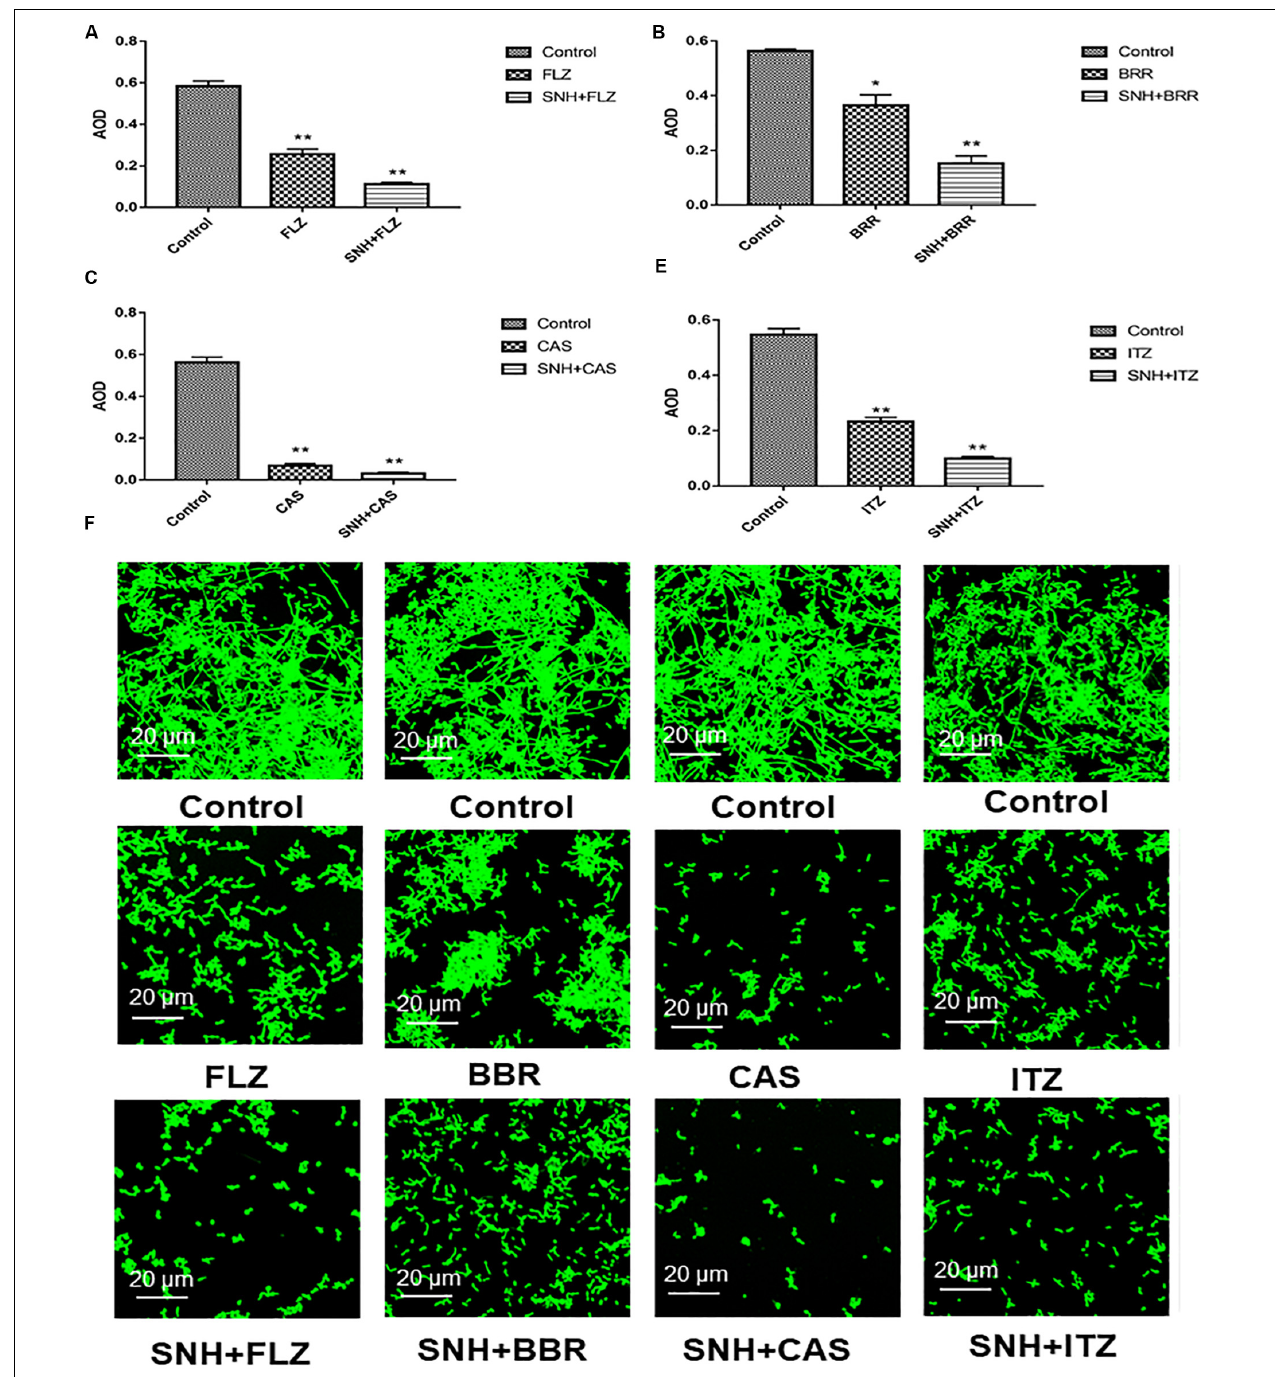
FIGURE 4 | (A–E) Analyze the average optical density (AOD) of SNH and FLZ, BBR, CAS, ITZ on C. albicans SC5314 biofilm by Image J, respectively. The drug-free strain-containing medium was set as the control. Data are shown as mean ± SD. ** p < 0.01 and * p < 0.05, compared with the control. (F) Observation of morphological changes of SNH and FLZ, BBR, CAS, ITZ on C. albicans SC5314 biofilm by CLSM ( × 400), respectively. The initial inoculum was newly prepared at 2 × 10 6 CFU/mL. The drug-free strain-containing medium was set as the control.